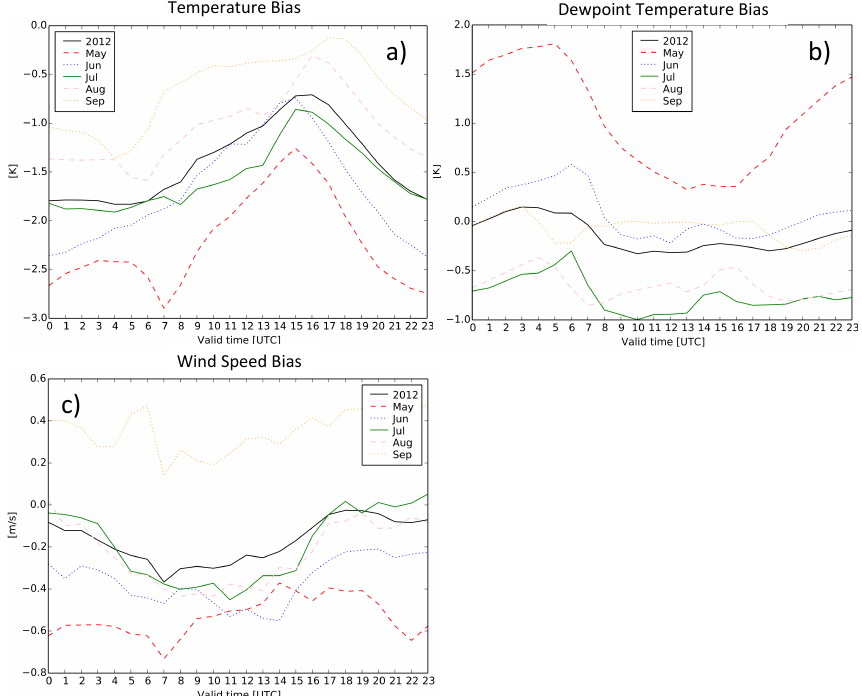
Figure 3. WRF v3.4.1 model bias by time of day (UTC; subtract 8h for Alaska Daylight Savings Time, AKDT) for (a) temperature (K), (b) dewpoint temperature (K), and (c) wind speed (ms − 1 ). Each curve and color indicates a different period of time (either monthly or the full 2012 campaign) over which the errors are computed.